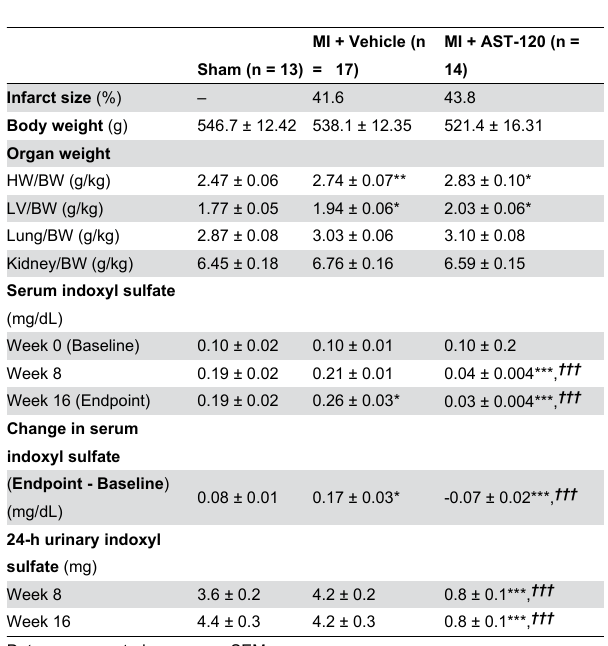
Table 1. Infarct size, tissue weights and indoxyl sulfate